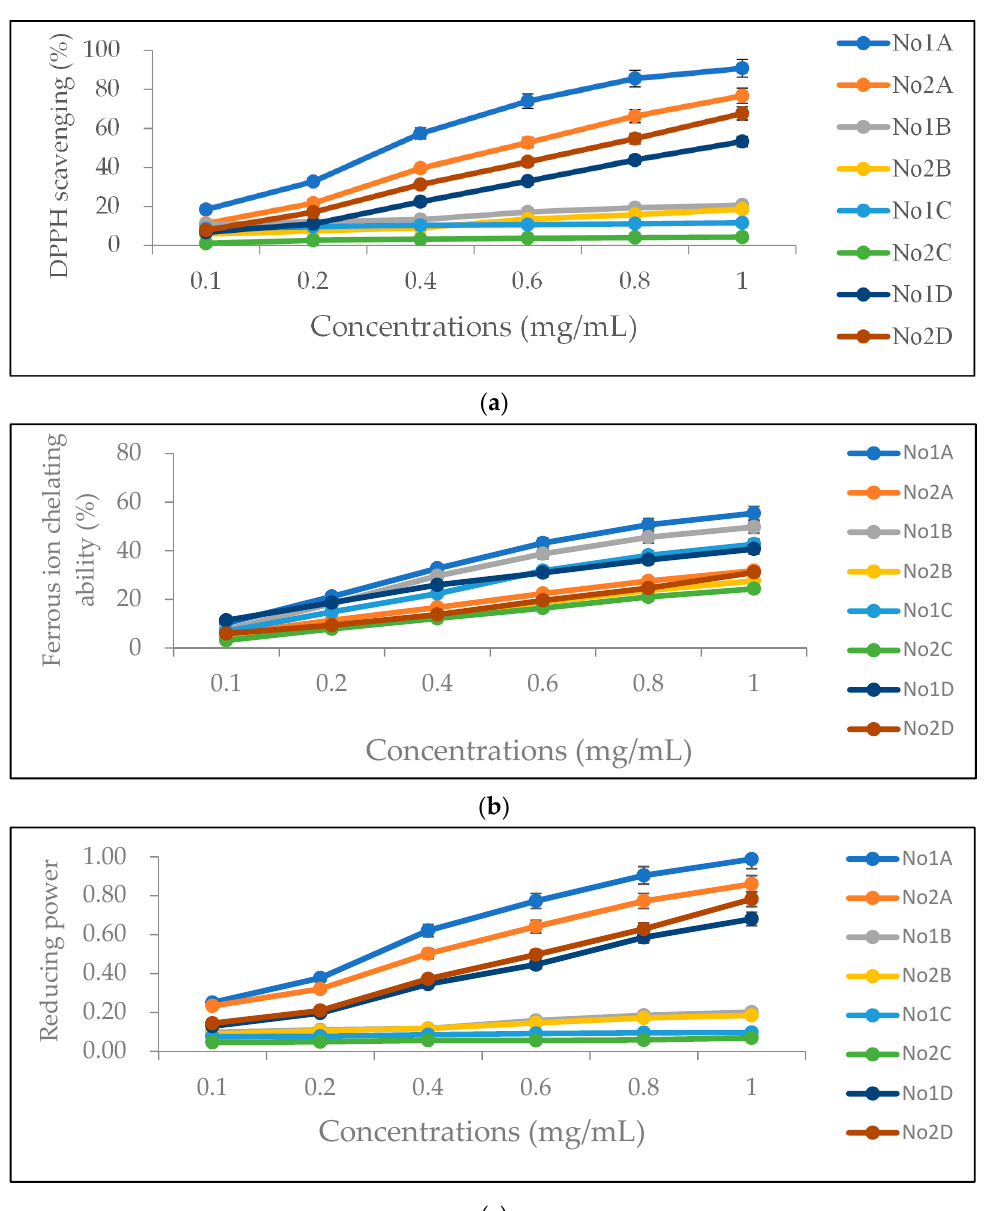
Figure 1. DPPH radical scavenging activity ( a ), ferrous ion chelating ability ( b ), and reducing power ( c ) of the extracts obtained with different solvents from No. 1 and No. 2. No. 1A and No. 2A are ethanol extracts, No. 1B and No. 2B are ethyl acetate extracts, No. 1C and No. 2C are n-hexane extracts, and No. 1D and No. 2D are pure-water extracts.